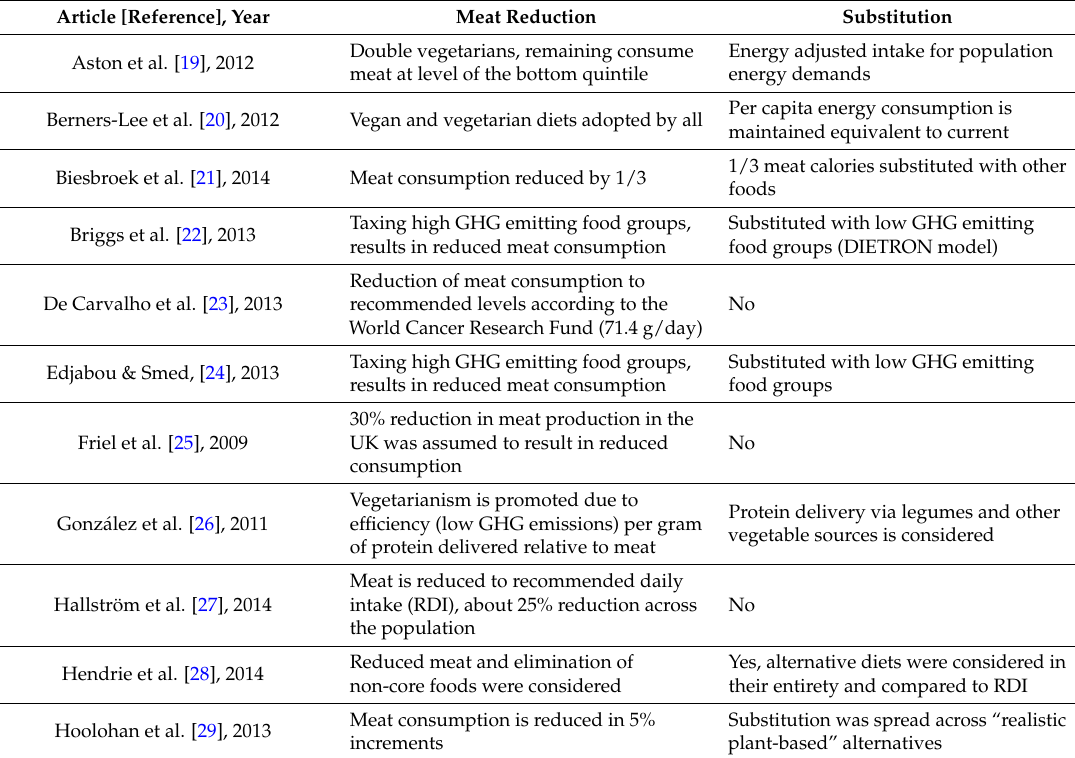
Table 4. Diet Articles—Meat reduction and substitution